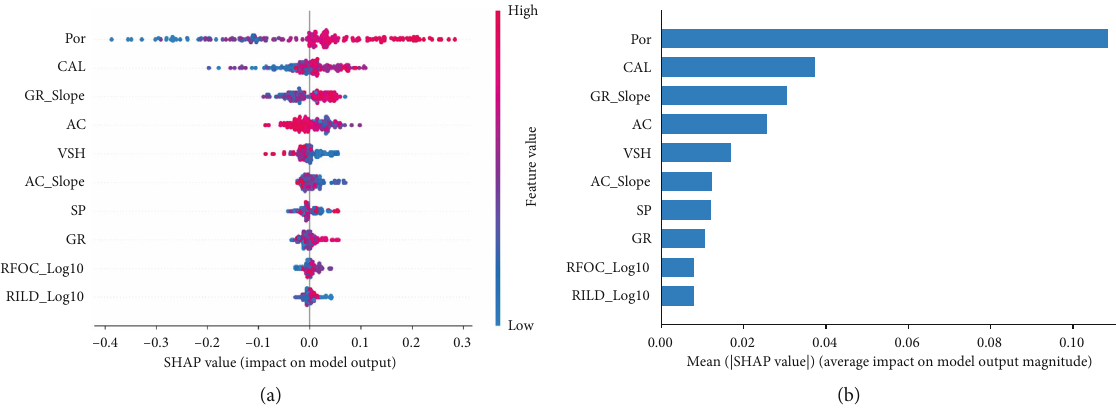
Figure 7: Global model explanation results by SHAP. (a) SHAP value distribution. (b) Feature importance